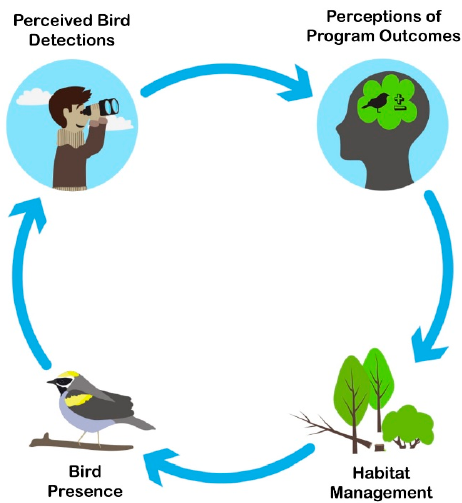
Figure 1. Hypothesized early successional forest coupled human and natural system at the property scale.